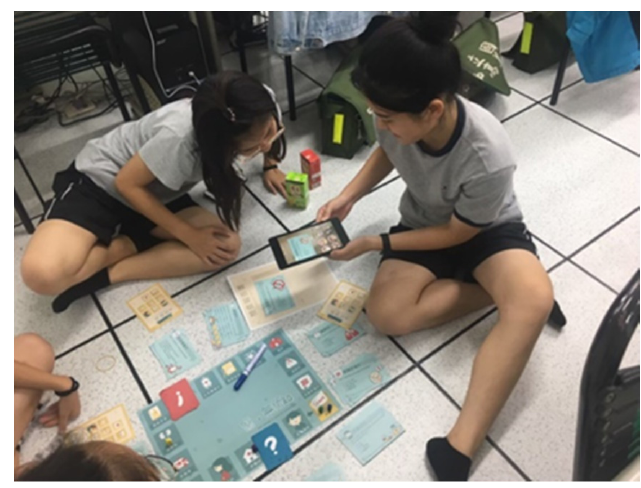
Figure 4. Experimental group playing scene. Electronics 2020 , 9 , x FOR PEER REVIEW